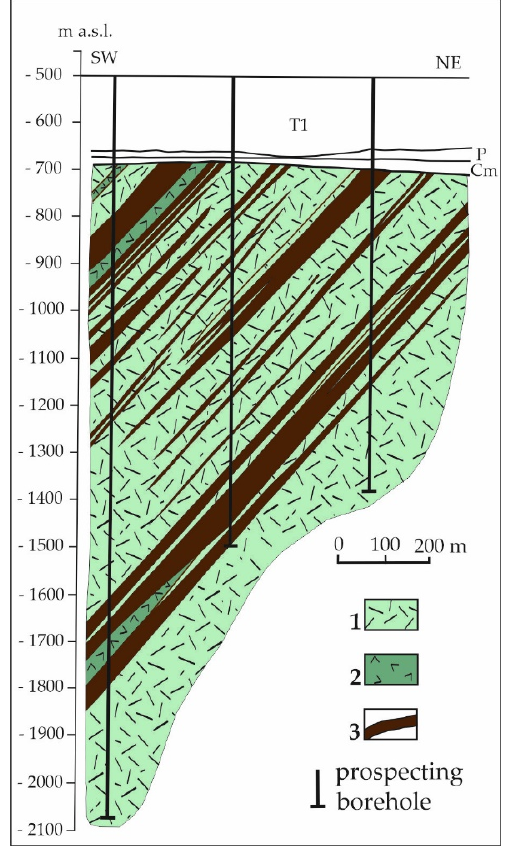
Figure 2. Schematic geological cross section (without Cenozoic sedimentary rock cover) of the Krzemianka Fe-Ti-V ore deposit in NE Poland (modified after [39]). Abbreviations: 1—anorthosite;